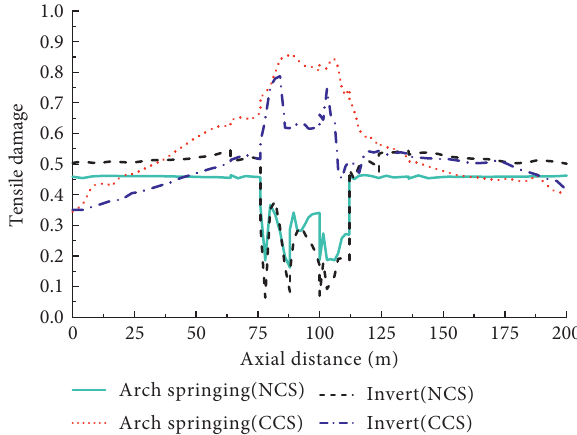
Figure 12: Damage distribution along the